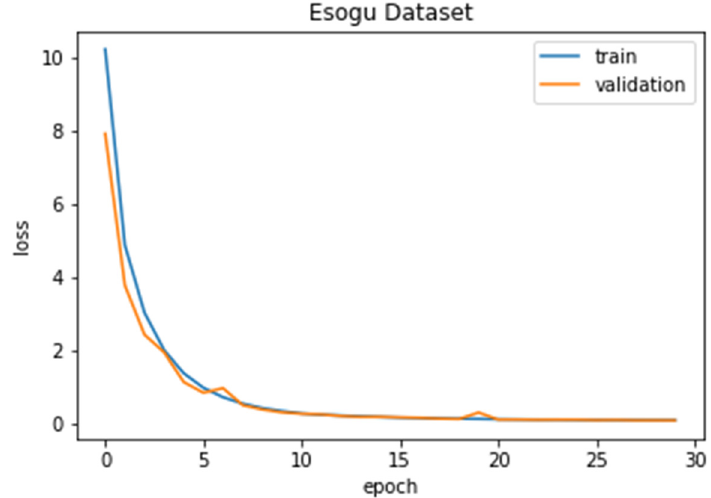
Figure 6. Loss-epoch graph of the proposed method on the ESOGU in-house dataset.